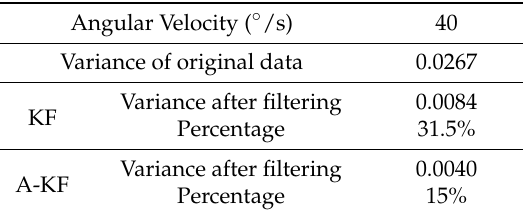
Table 2. The filtering result comparison of the Kalman filtering with adjustments (A-KF) method and the Kalman filtering method based on the ARMIA model (KF) method.